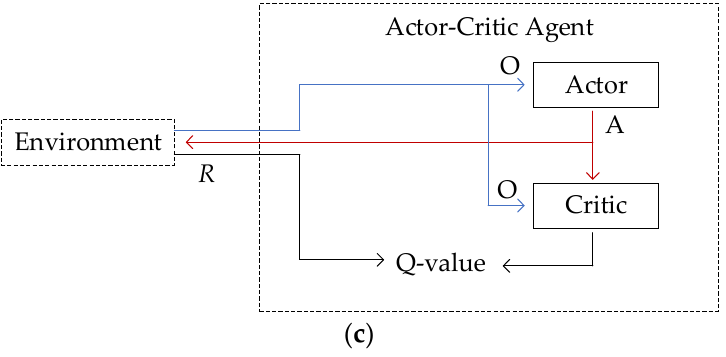
Figure 3. Architectures: ( a ) actor, ( b ) critic, ( c ) actor-critic. The actor target network 𝜇 (cid:4593) (𝑂, 𝜃 (cid:3091) and critic target network 𝑄 (cid:4593) (𝑂, 𝐴, 𝜃 (cid:3018) are time − delayed copies of their original networks that slowly track the actor and critic net- works. The main role of the target networks is to improve the stability in the learning by (cid:4594) (cid:4594) periodically saving the actor and critic parameters. The weight parameters 𝜃 (cid:3091) and 𝜃 (cid:3018) of the actor and critic target networks are updated by the equations below for 𝜏 ≪ 1 :